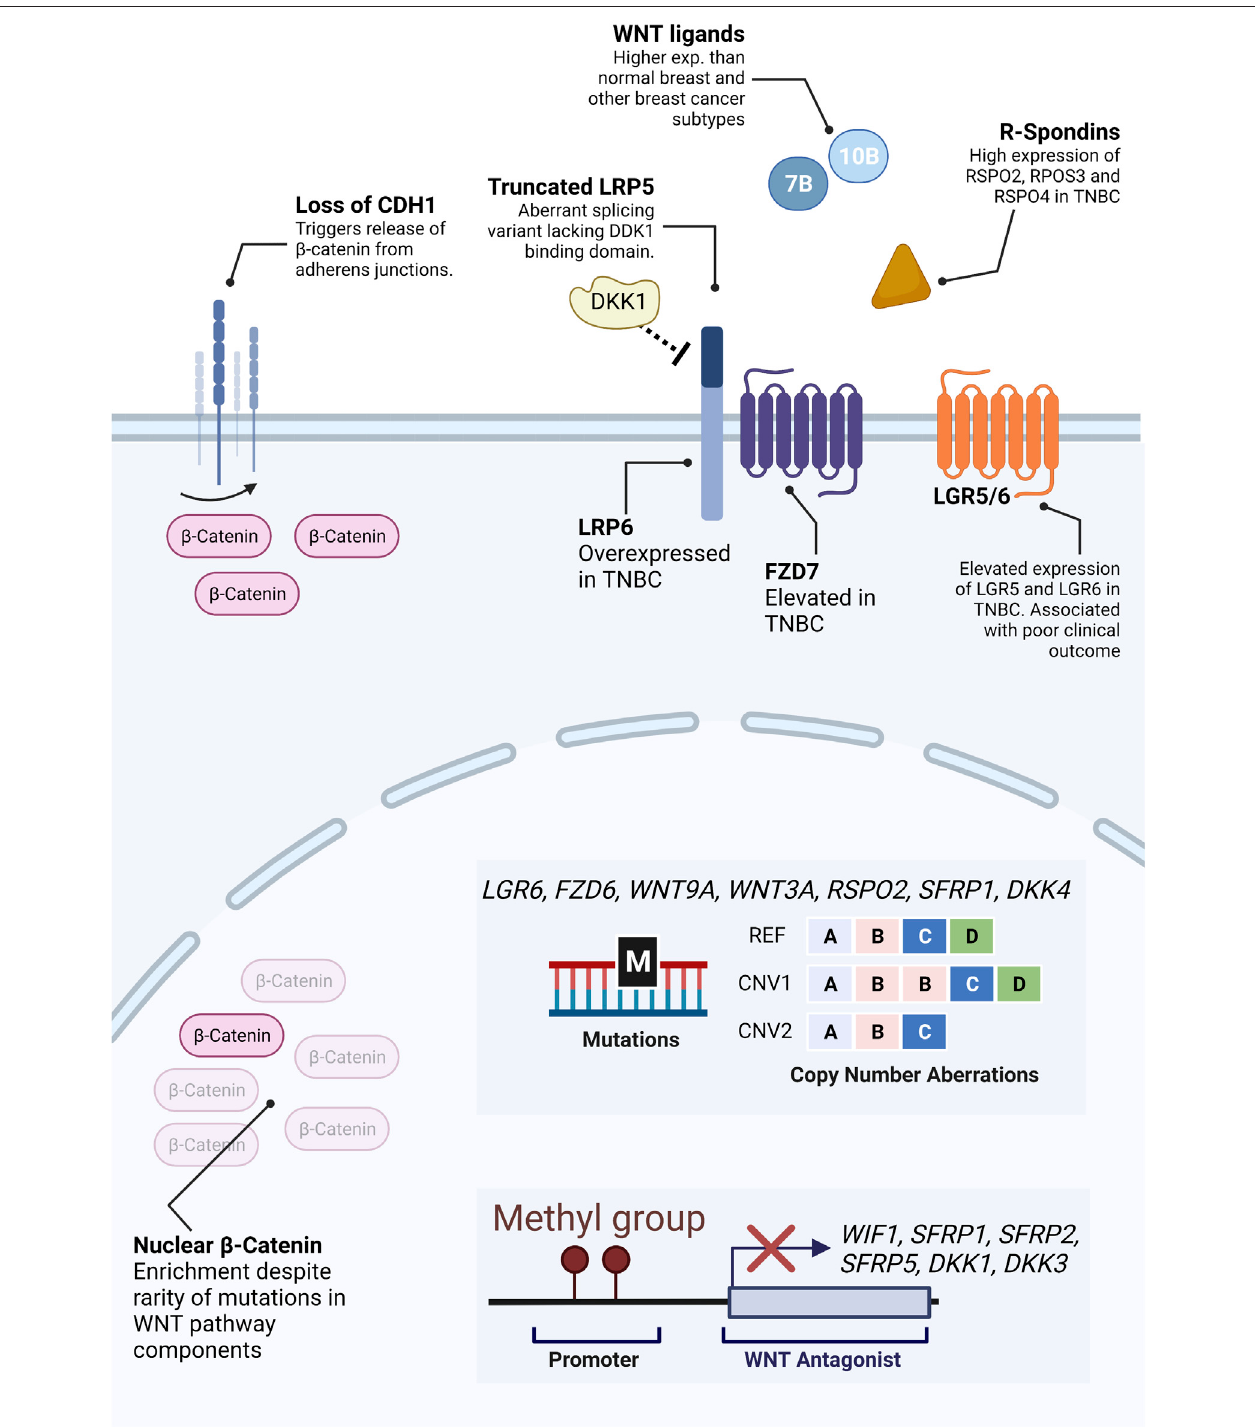
FIGURE 4 | Molecular alterations in Wnt pathway components. Unlike colorectal cancer, direct alterations in β -catenin or β -catenin regulating proteins are virtually inexistent in TNBC. Notwithstanding, a signi fi cant proportion of TNBC patients display aberrant levels of β -catenin expression. While there is no clear answer to why, several possible mechanisms have been described to contribute to aberrant β -catenin levels in TNBC. These include the release of β -catenin from plasma membrane poolsdue tolossofCDH1,mutationsorcopynumberaberrations (illustrativerepresentation – REF: reference,CNV1: duplicationofgeneB,CNV2: deletion ofgene D) in receptors and secreted Wnt agonists and antagonists, hypermethylation of promoters of genes encoding antagonists, expression of truncated antagonist receptors, etc.